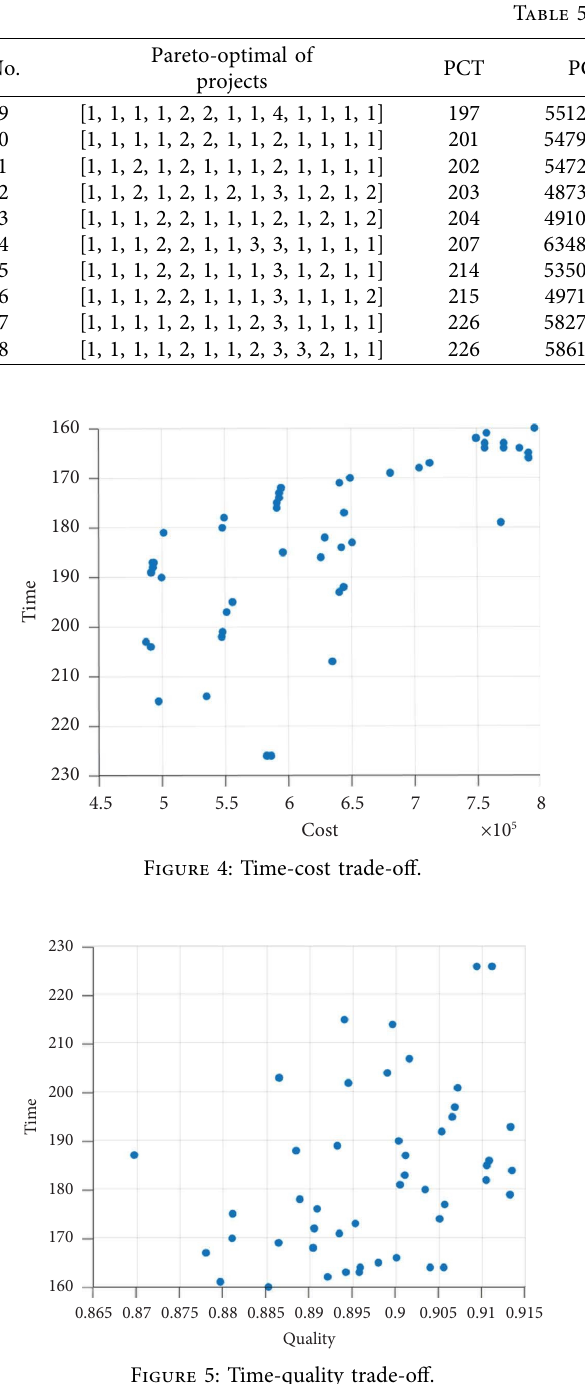
Figure 7: Cost-quality